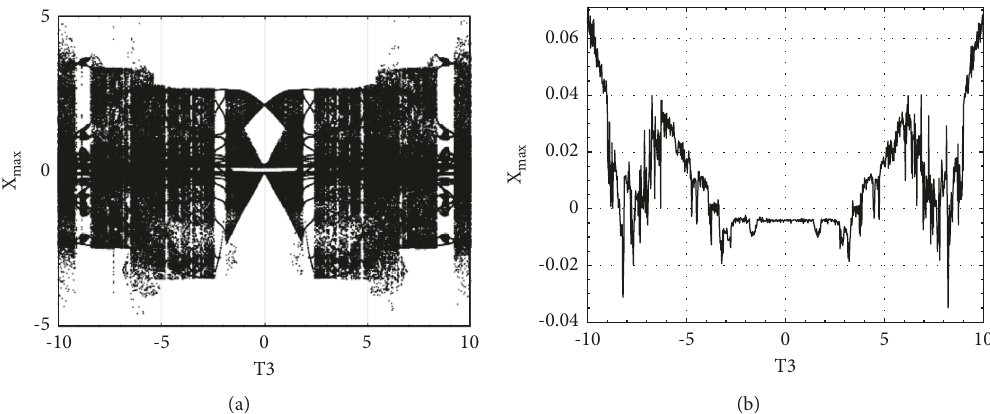
� 0.00025; F � 1Hz. 3